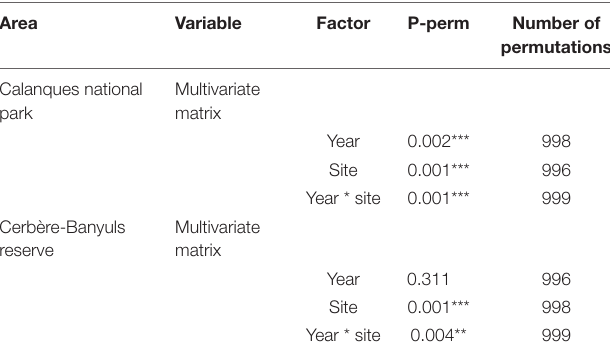
TABLE 3 | Results of permutation analyzes of variance (PERMANOVA) in the Cerbère-Banyuls reserve and the Calanques national park MPAs via a design incorporating the “site” and “year” factors, applied for the multivariate matrix (maximum size; basal diameter; number of branches) and each univariate